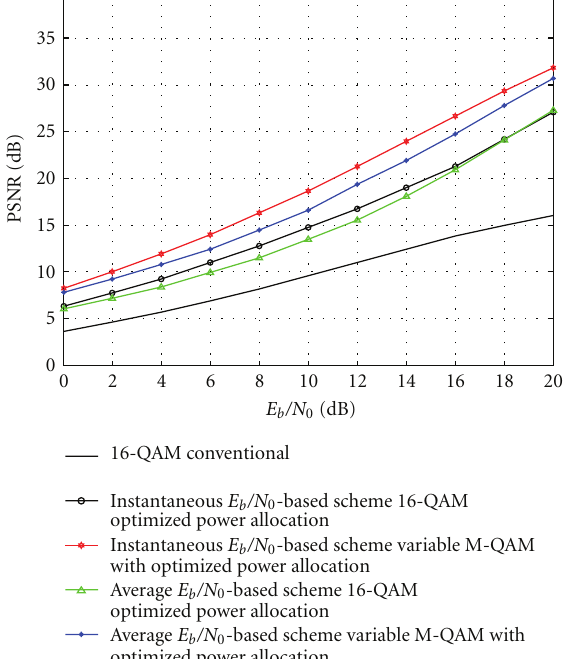
Figure 8: PSNR performance in Rayleigh